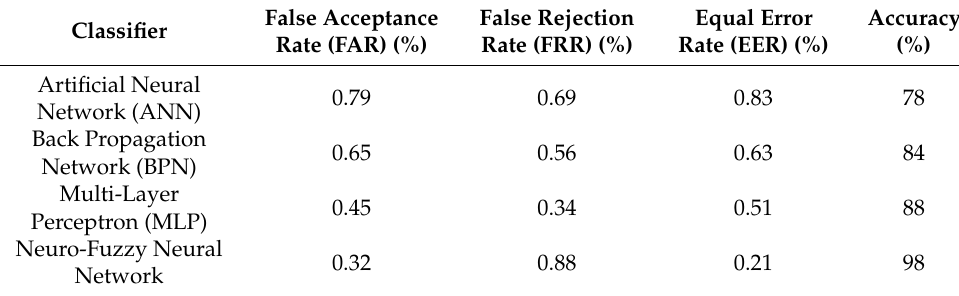
Table 2. Comparative analysis of different classifiers.